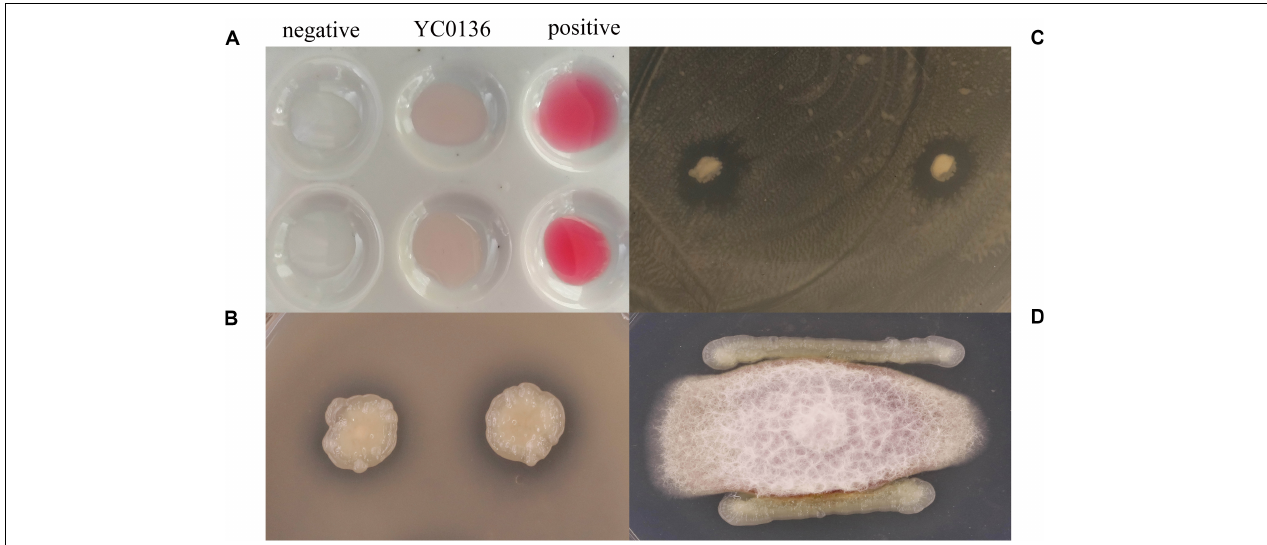
FIGURE 1 | Growth-promoting characteristics of strain YC0136. (A) Detection of IAA secretion. A single clone of strain YC0136 was inoculated in Landy liquid medium and cultured for 4 days at 25 ◦ C, 90 rpm. Salkowski solution was then used to detect IAA secretion. A standard solution with 50 mg/L IAA was used as a positive control. Landy medium without inoculation was used as a negative control. (B) Qualitative analysis of phosphate solubilization. A single clone of strain YC0136 was cultivated on LB medium at 37 ◦ C. The pure bacterial culture was inoculated onto organophosphorus culture medium for qualitative analysis of phosphate solubilization. (C) Strain YC0136 inhibits the growth of R. solanacearum. R. solanacearum was coated on LB ager medium, and then strain YC0136 was inoculated onto the coated plate and cultured for 24 h at 37 ◦ C. (D) Strain YC0136 inhibits the growth of F. moniliforme. Hyphae of F. moniliforme were placed in the center of PDA medium and cultured for 2 days at 28 ◦ C. Strain YC0136 was then streaked around the fungi and cultured at 28 ◦ C for another 2 days.